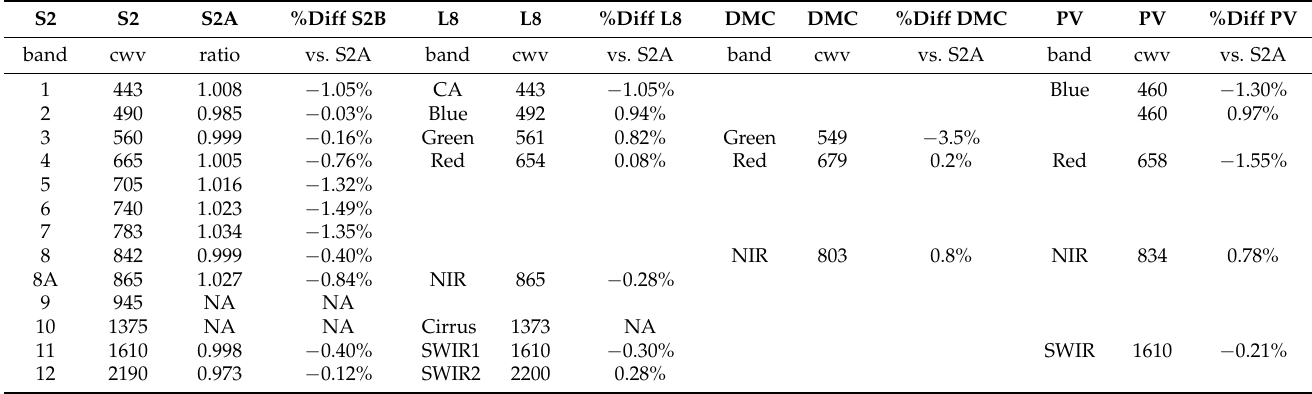
Table 5. Mean ratio (over all observations) of the satellite-measured TOA reflectances to the 6SV TOA reflectance reference simulations over Libya-4 (Table copied from